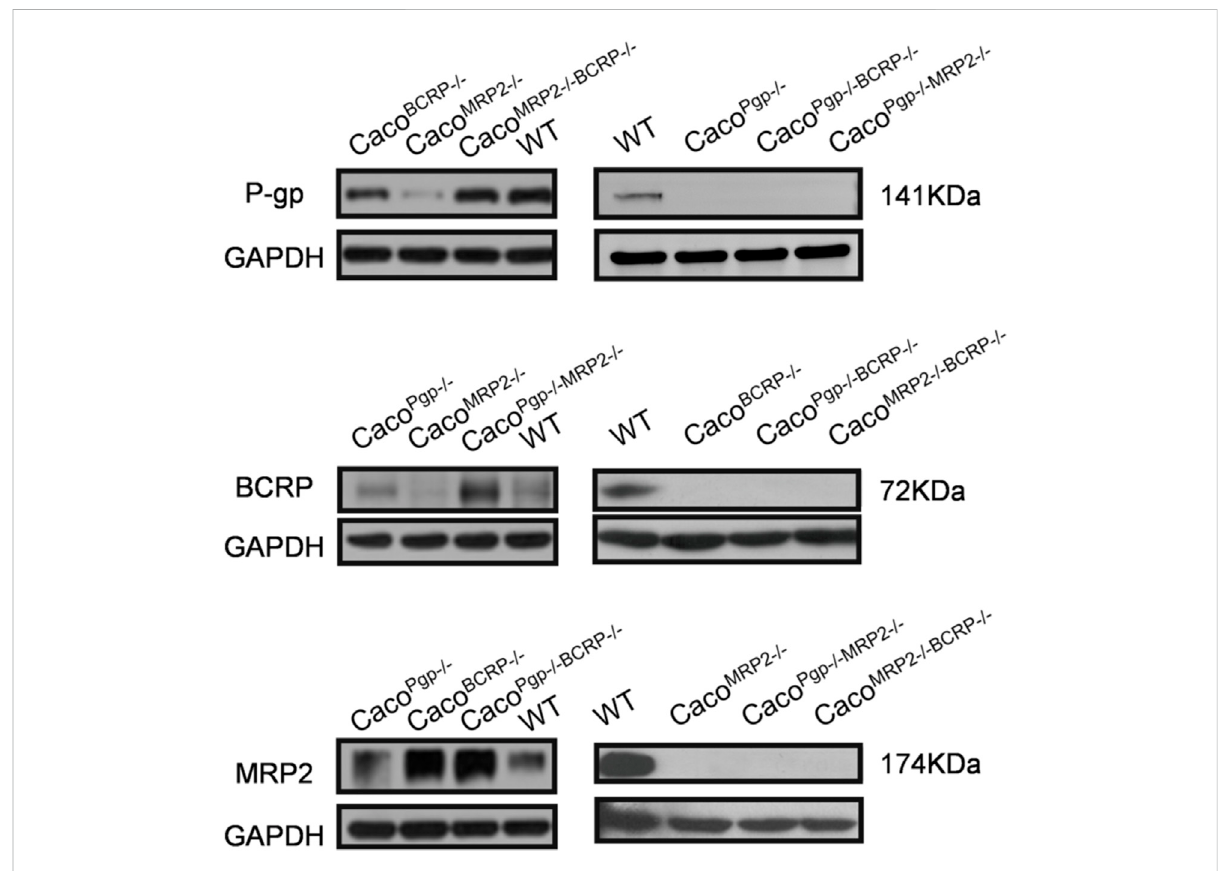
FIGURE 2 Western blot analysis of P-gp, BCRP and MRP2 protein expression in WT and KO cell lines. The left and right sides experiments were independent experiments.